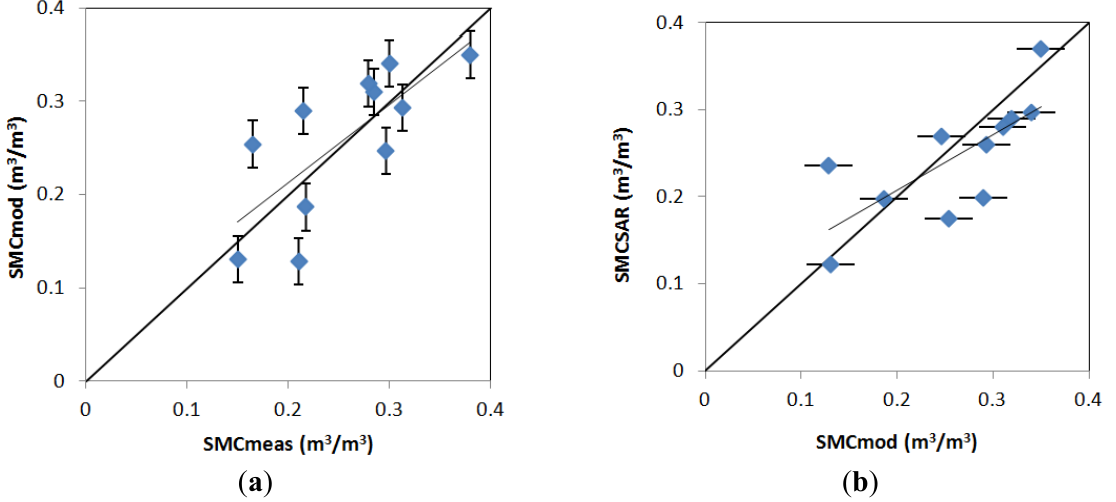
, in m 3 /m 3 ). ( b ) SMC estimated from SAR (SMC meas